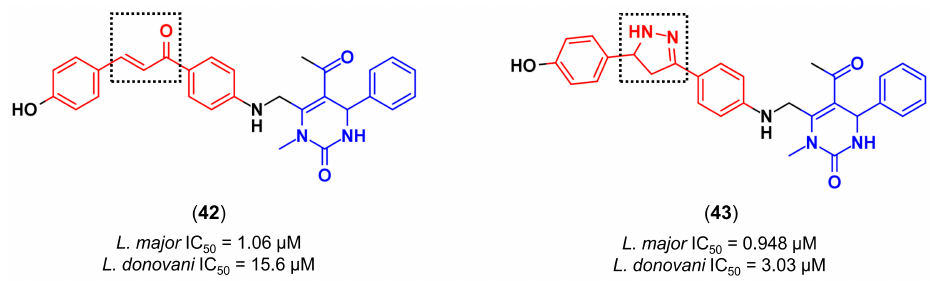
Figure 15. Anti-leishmanial chalcone-dihydropyrimidine hybrids (red and blue, respectively) prioritized by molecular docking studies [151].